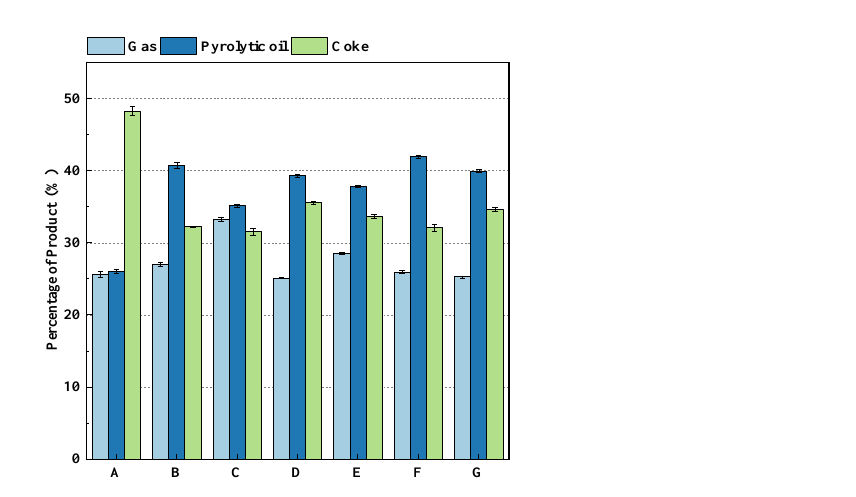
Figure 3. Product yield of co-pyrolysis from HR and ISW for Groups A–G. Compared with HR pyrolysis (A) alone, HR and ISW1 co-pyrolysis (E) reduced the coke yield from 48.25% to 37.8%. The yield of pyrolysis gas and oil increased by 2.85% and 11.7%, respectively, which showed that the co-pyrolysis of HR and ISW1 was beneficial to the occurrence of a pyrolytic reaction and the formation of light molecules. Compared with Groups A, B, and E, with the decrease in the H/C ratio, the yield of pyrolysis oil increased from 37.8% to 40.75%, and the content of coke slightly decreased. Similar results were obtained for Groups A, F, and G. This may have been due to the decrease in the H/C ratio in the raw materials, which promoted the co-pyrolytic process. It may have also been because some components of HR and ISW2 reacted with one another to promote co-pyrolysis. The S/C ratio also had a similar effect on the co-pyrolysis of HR and ISW. The co- pyrolysis of HR and ISW2 had a higher oil production rate than that of HR and ISW1, which may have been because there were more organic compounds in rubber, which are conducive to the formation of pyrolysis oil. In Groups A, F, and G, with the decrease in the S/C ratio, the yield of pyrolysis gas and oil slightly decreased, and the proportion of coke slightly increased, which was similar to the co-pyrolytic trend of HR and ISW1, indicating that the S/C ratio had little effect on the yield of co-pyrolytic products. Alkanes, alkenes, and aromatics were the main components of pyrolysis oil. Different feedstocks and temperatures changed the co-pyrolytic conditions, thus changing the distri- bution of oil products to varying degrees. As shown in Figure 4, when HR and ISW1 were co-pyrolyzed and the temperature was increased from 500 to 700 ◦ C (Groups D, B, and C), the alkene content increased from 14% to 25.6%, the aromatic content increased from 19.5% to 41.2%, and the alkane content decreased from 66.5% to 55.4%. By increasing the H/C ratio (Groups A, B, and E) of the pyrolytic feedstock, the yield of olefins also increased to a certain extent, but it was lower than that of HR pyrolysis alone. This may have been due to a mutual reaction between materials caused by co-pyrolysis, which promoted the decomposition of olefins into alkanes. With the increase in the H/C ratio, the production of aromatics decreased from 28% to 22.5%. When HR and ISW2 were co-pyrolyzed, with the increase in the S/C ratio, the alkene content increased from 24.3% to 31.1%, while the amount of alkanes and aromatics decreased. In conclusion, when the temperature was between 600 and 700 ◦ C, more pyrolysis oil could be produced from HR and ISW co-pyrolysis. When the H/C and S/C ratios were 1.3 and 0.007, respectively, more pyrolysis oil containing olefin could be